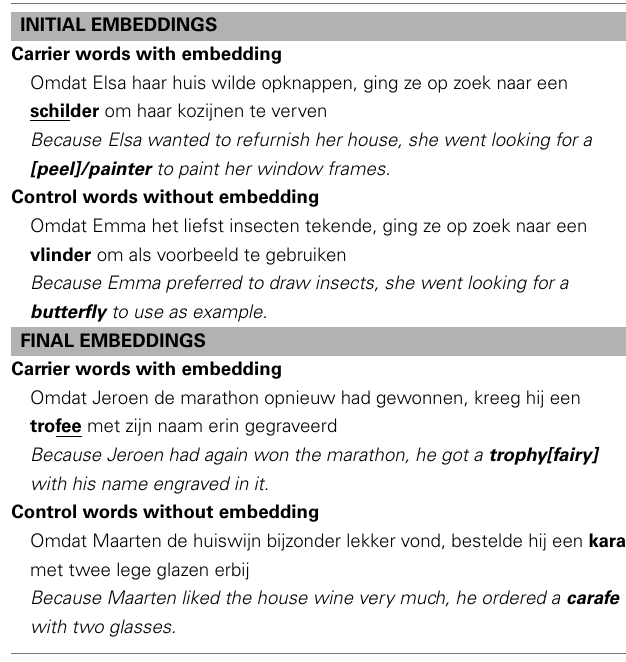
Table 2 | Example materials for initial and final